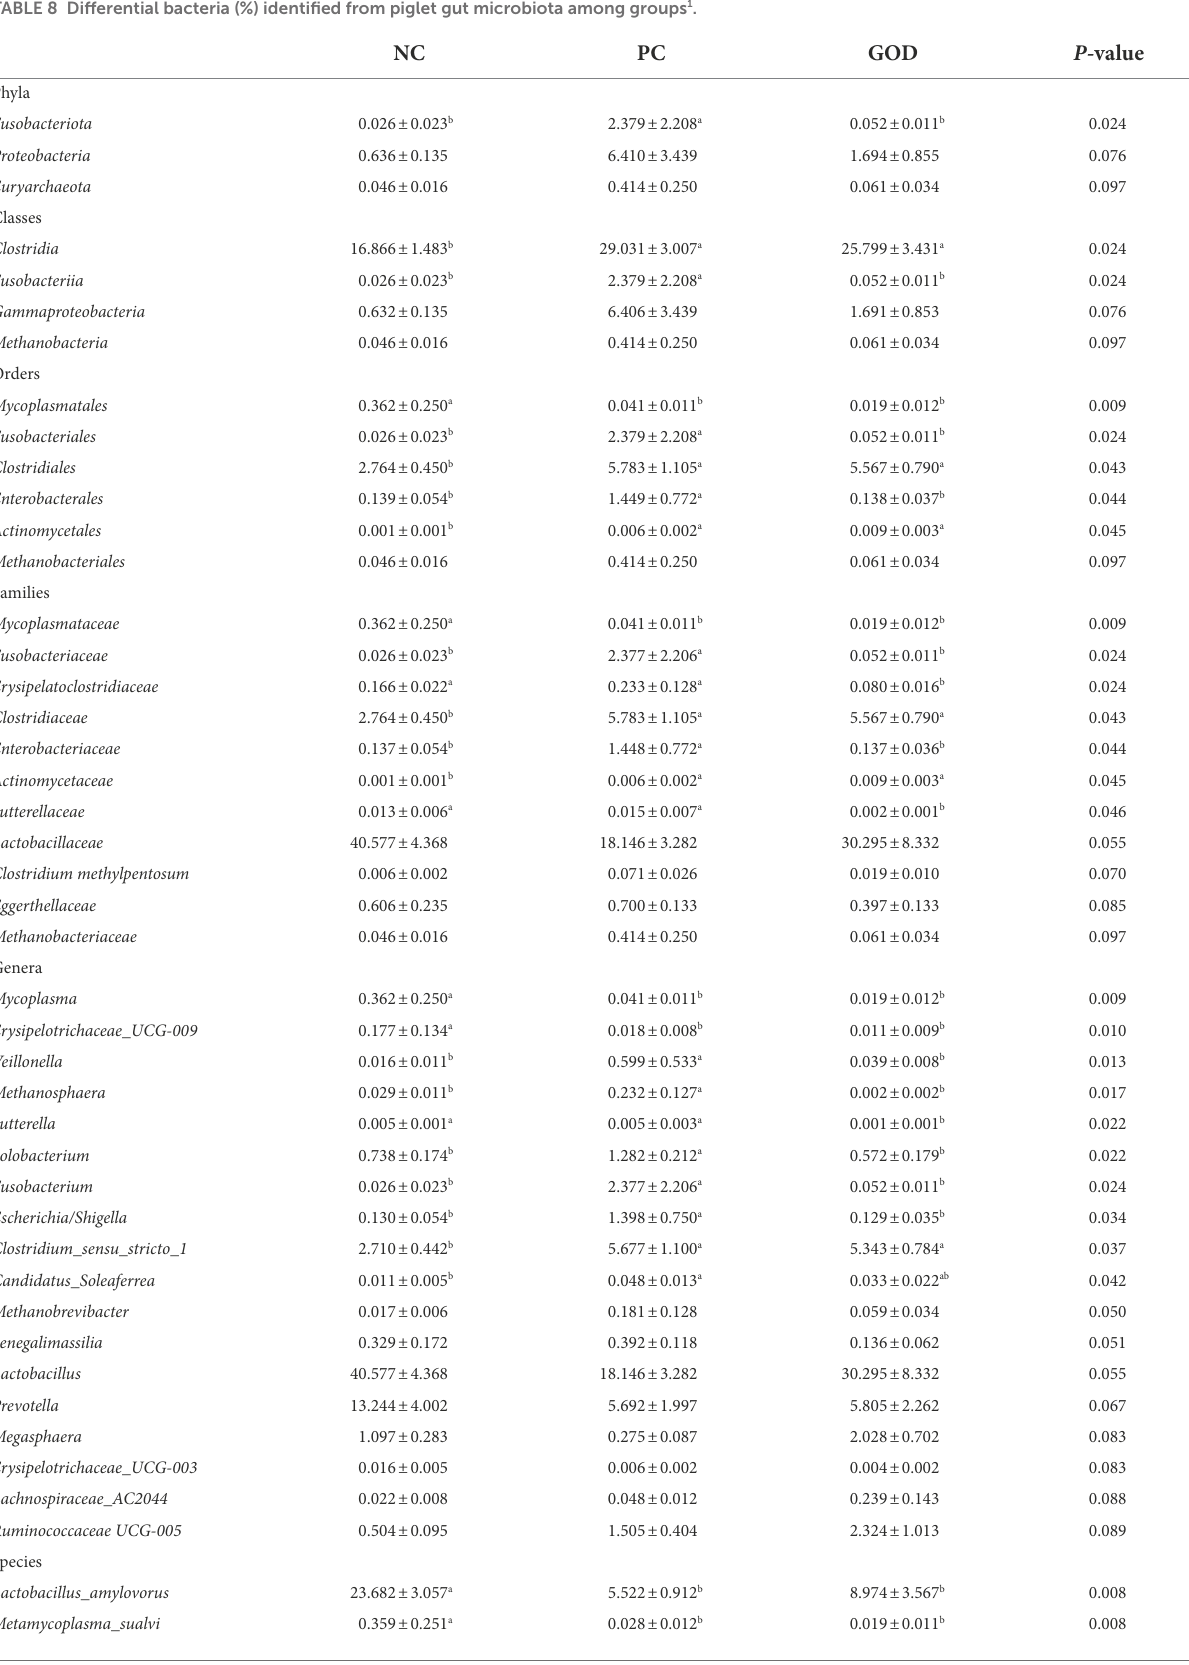
TABLE 8 Differential bacteria (%) identified from piglet gut microbiota among groups 1